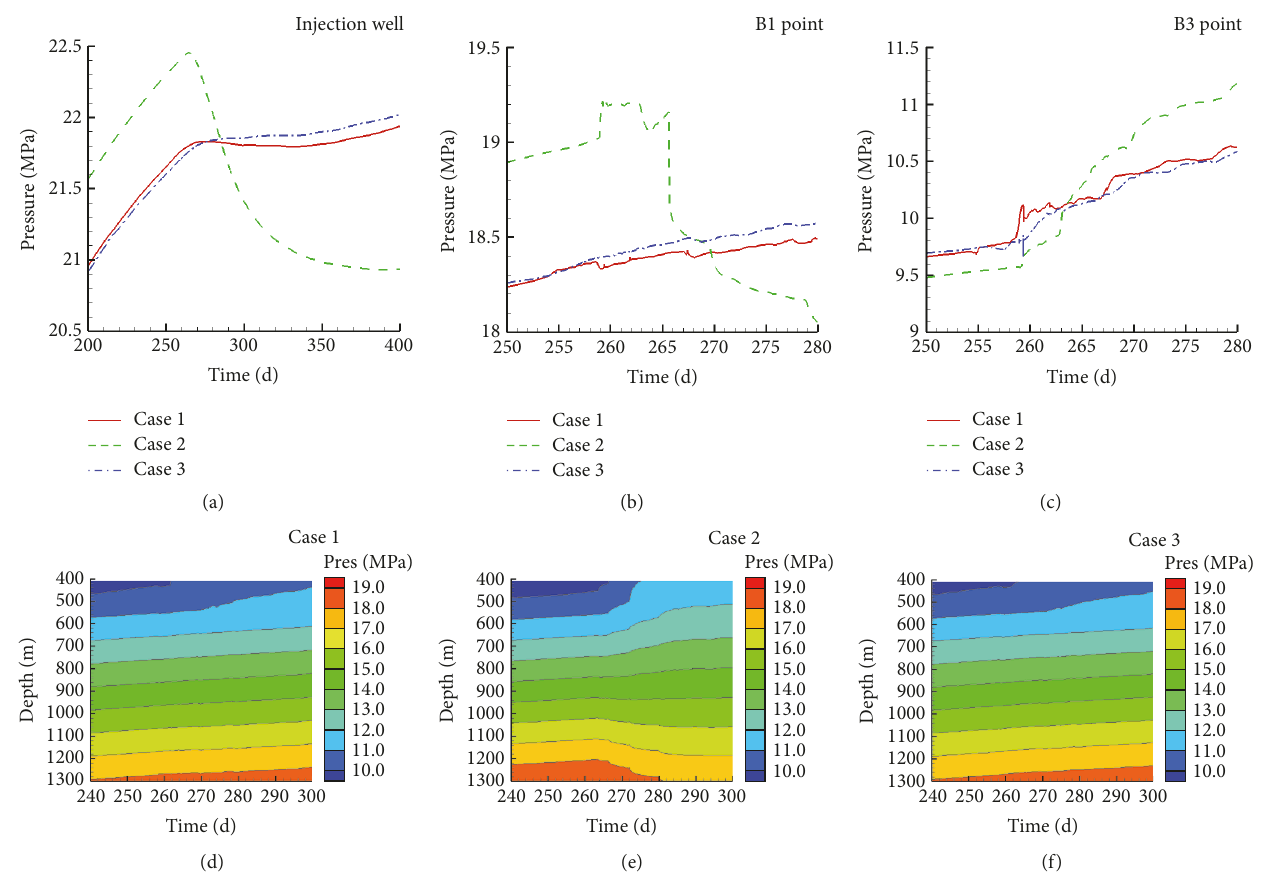
Figure 9: Pressure responses of CO 2 breakthrough at injection well and the fracture.